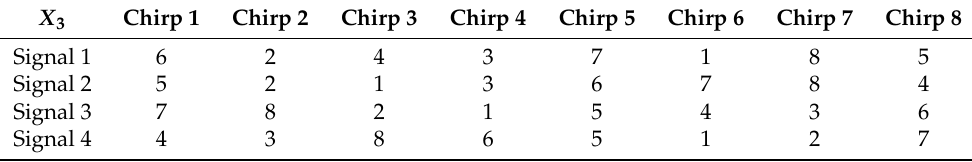
Table 3. Sub-chirp sequence code matrix of the optimal OFDM-NLFM waveform